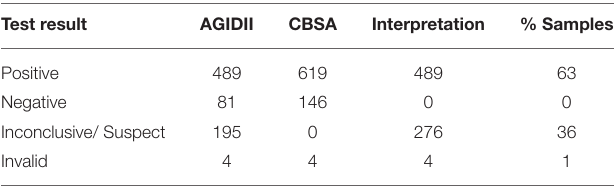
TABLE 3 | Test results and interpretation of rough strain Brucella canis tests for 769 retrospective samples.